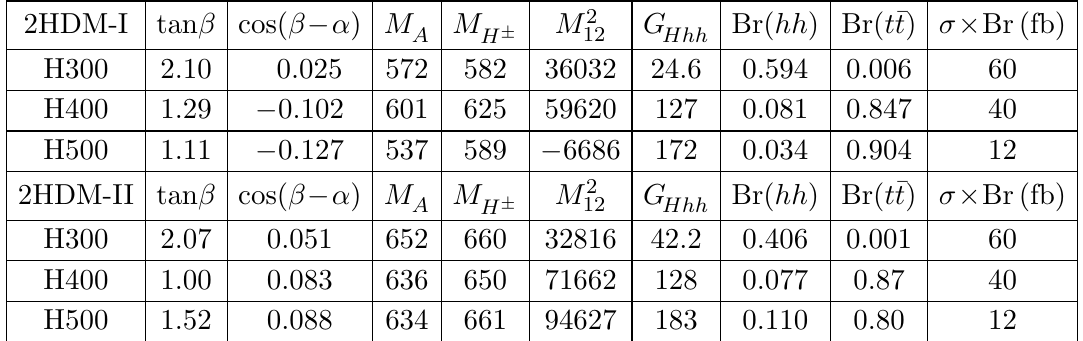
Table 3 . Explicit parameter samples to realize the benchmarks (2.18) for the 2HDM-I and 2HDM- II, respectively. Here Br( hh ) = Br( H 0 ! hh ) and Br( t (cid:22) t ) = Br( H 0 ! t (cid:22) t ). All the mass parameters and the cubic Higgs coupling G are in the unit of Hhh